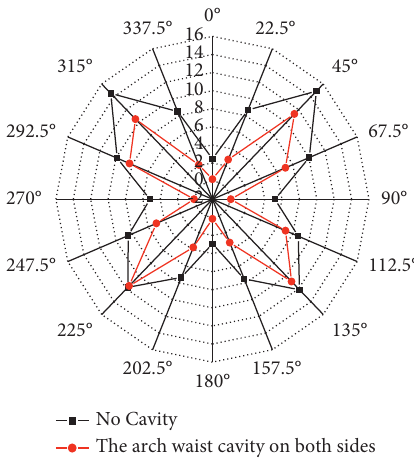
Figure 23: Safety coefficient of the segment cross section of the cavity behind the arch waist on both sides.